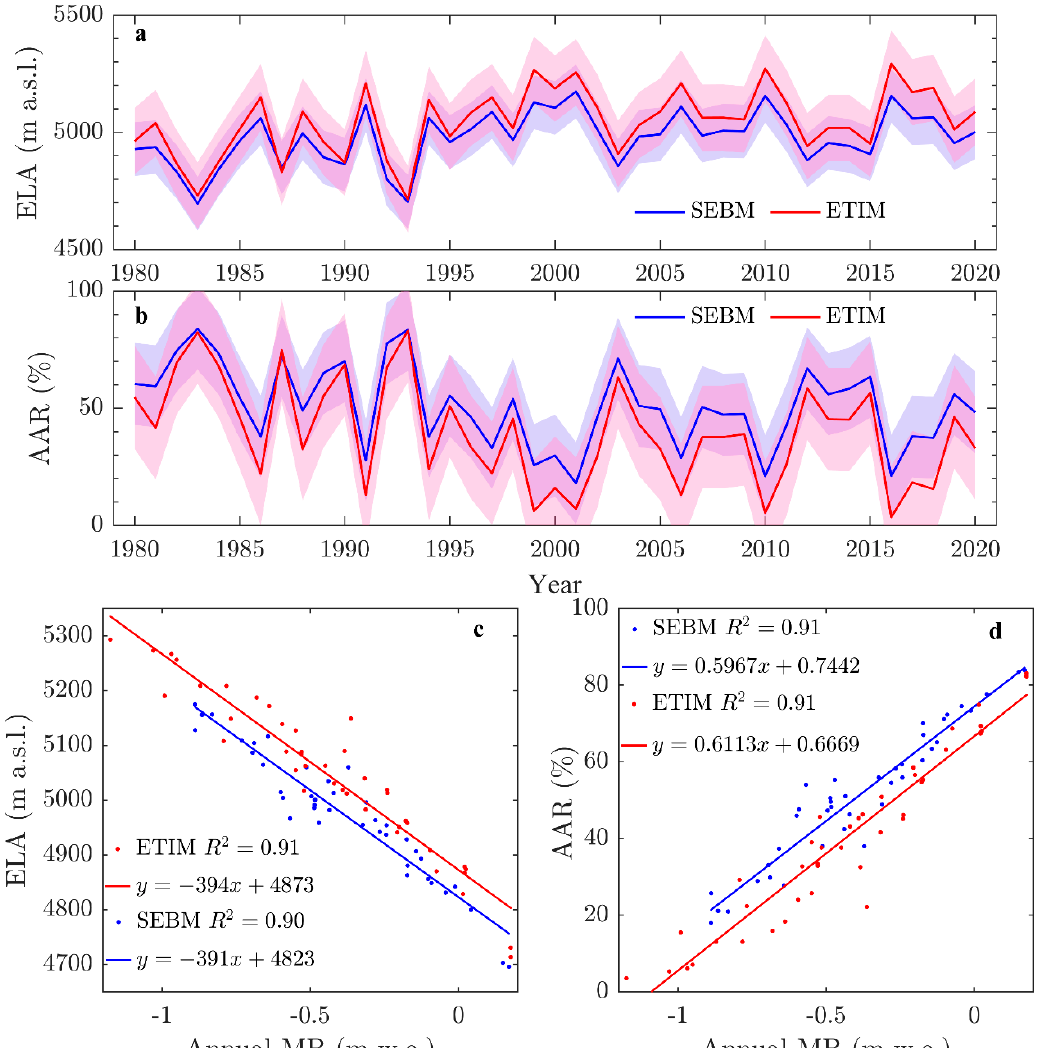
Figure 8. ( a ) Equilibrium-line altitude (ELA) and ( b ) accumulation area ratio (AAR) modeled by SEBM and ETIM, and fitting function of ELA ( c ) and AAR ( d ) with annual MB.